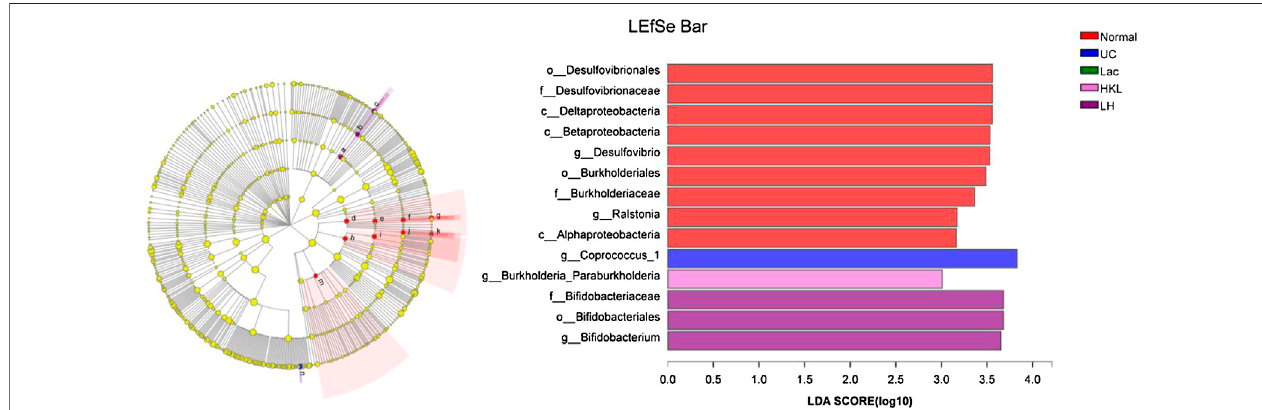
FIGURE 7 | LEfSe cladogram (LDA = 3) and LDA bar chart ( n = 5~6). Circular cladogram for niche specialization of microbial compositions in fi ve groups using the LEfSe analysis of the abundance patterns of bacterial taxa. Circles represent taxonomic categories of organisms from the genus level (outermost circle) to the phylum level (innermost circle). Within each given taxon, each small circle represents its lower clade. Yellow nodes indicate no statistically signi fi cant differences in a given taxon between the samples of the fi ve groups. The size of the node is proportional to the LDA score. The links (lines) between the nodes mean hypothetical phylogenetic relationships among organisms, which can be traced back to where the lines branch off (hypothetical